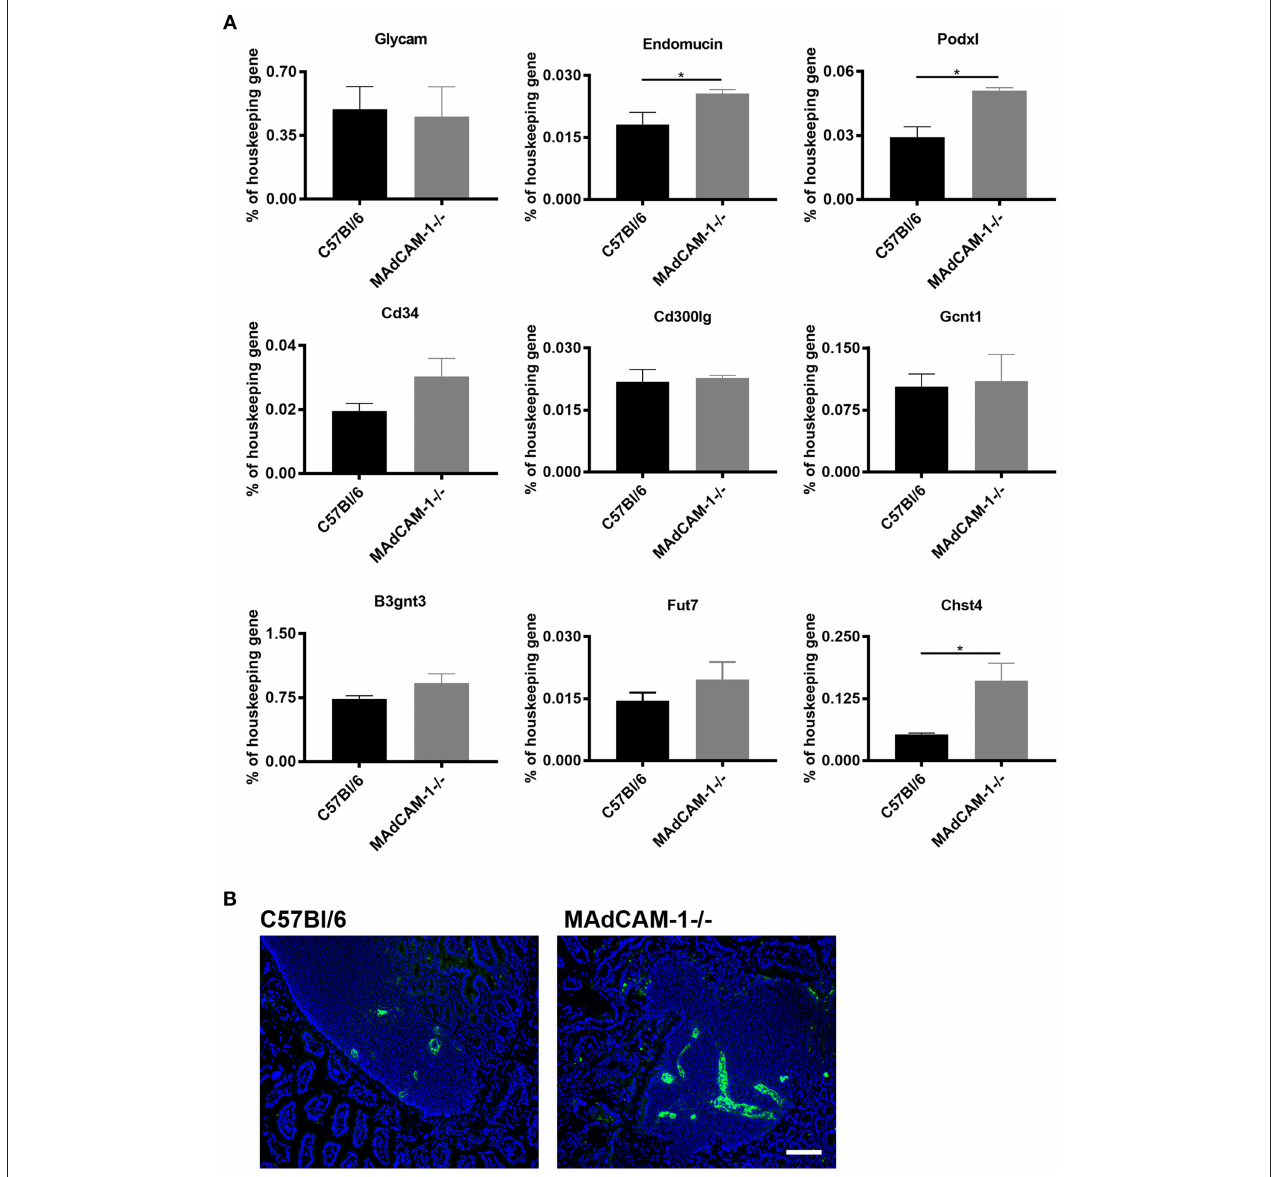
FIGURE 3 | Comparison of expression of mRNA expression for peripheral lymph node addressin core proteins and glycosylation enzymes in Peyer’s patches between MAdCAM-1 − / − and wild-type mice and the expression of MECA-79 PNAd epitope. (A) qPCR analyses were performed for the various core proteins (GlyCAM, endomucin, podocalyxin-like protein, CD34, and nepmucin) and glycosylation enzymes, expressed as a mRNA level relative to β -actin ( n = 6; mean ± SEM, in a duplicate measurement; * p < 0.05). (B) Immunofluorescence detection of MECA-79 epitope (green) in wild-type (left) and MAdCAM-1 − / − Peyer’s patches with Hoechst nuclear counterstaining (blue) (representative example of a cohort of 3 mice; scale bar = 100 µ